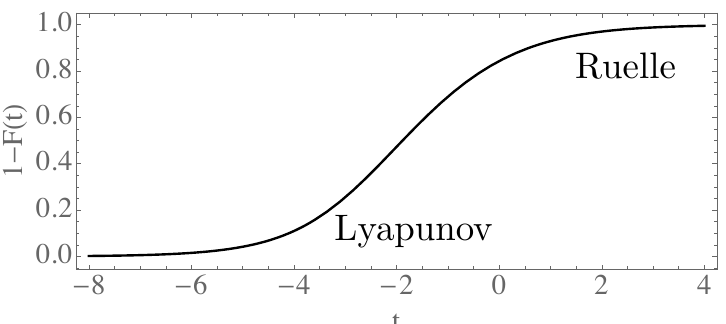
Figure 1 . Plot of the behavior of 1 (cid:0) F ( t ) as a function of time t in the limit c ! 1 with cz (cid:12)xed, with h L = h H = 1 . F ( t ) is absolute value of the out-of-order correlator hO L O H O L O H i (cid:12) 2 t (cid:17) (cid:0) log( cz= 6). The initial \Lyapunov" growth and the later \Ruelle" decay are labeled as in